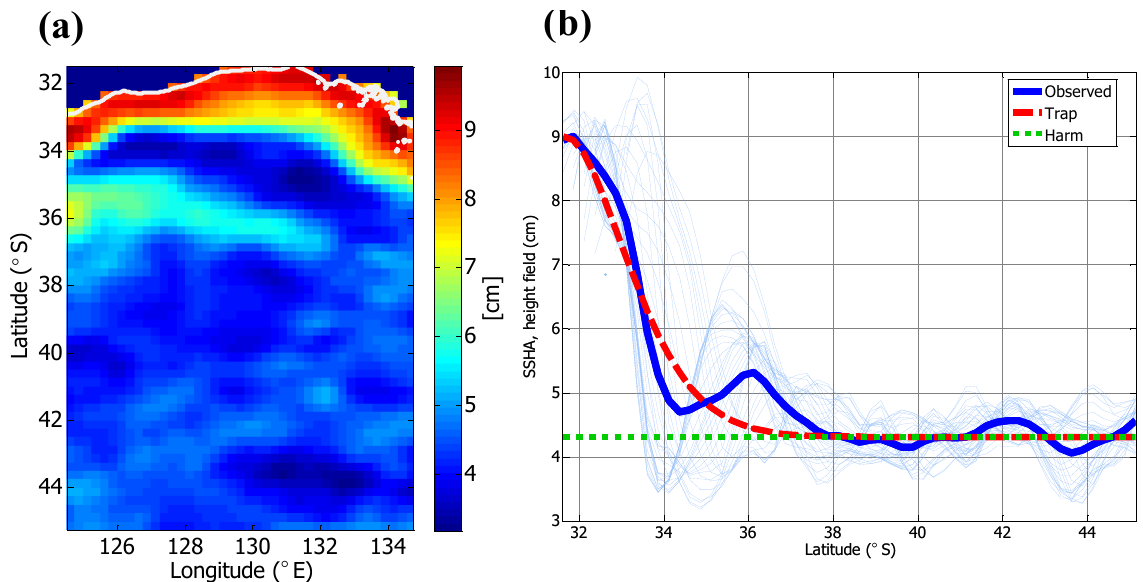
Figure 2. (a) The temporal standard deviation of satellite-derived SSHAs over the entire 20-year period poleward of the Great Australian Bight. The coastline is plotted in white. (b) Latitudinal cross sections of the data of panel (a) every 0.25 ◦ longitude (thin light-blue lines), the mean over all longitudes of the latitudinal cross sections (thick blue line) and the analytical expression for the meridional structure of the height field of trapped waves for zero zonal wavenumber and zero meridional mode number (dashed red line; see Eq. 5 below). The maximal trapped wave amplitude is set to match that of the mean observed cross section where the off-shore minimum is about 4cm since the temporal mean of Aviso’s original data is not zero. The analytical expression for the meridional structure of the height field of harmonic waves for k = 0 and l = 0 is constant, i.e., described by a straight line parallel to the abscissa at arbitrary value of the ordinate; here it is set to match the off-shore minimum of about 4cm (dotted green